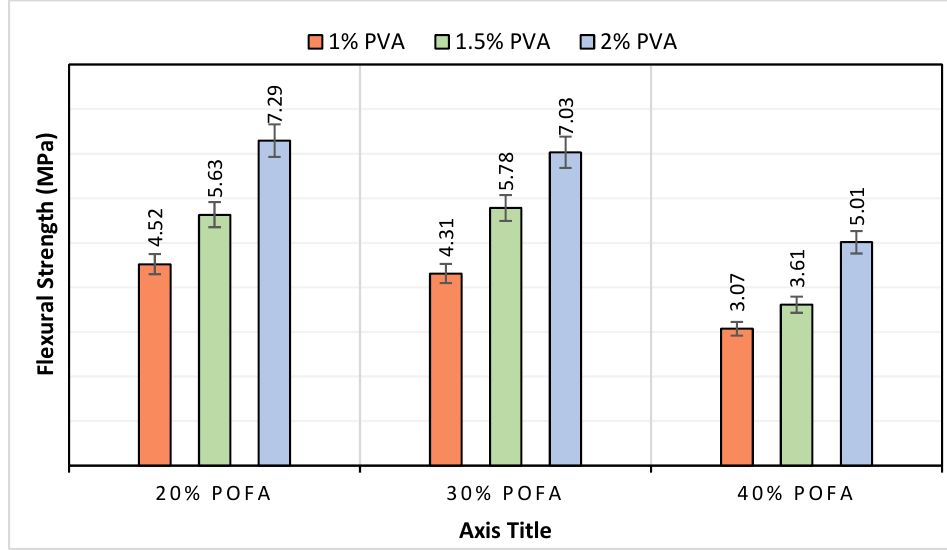
Figure 9. Flexural strength of POFA ECC mixes.